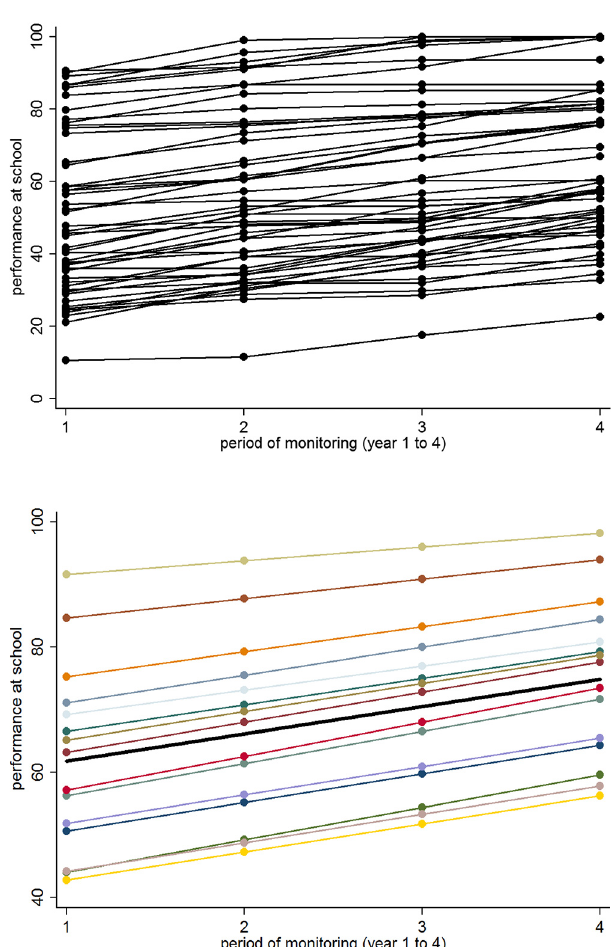
Figure 4. Temporal